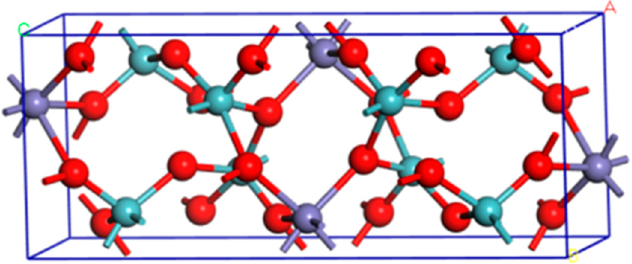
Figure 2. The optimized structure of FeNb 2 O 6 (the purple atoms are Fe atoms, the red atoms are O atoms, and the blue atoms are Nb atoms).